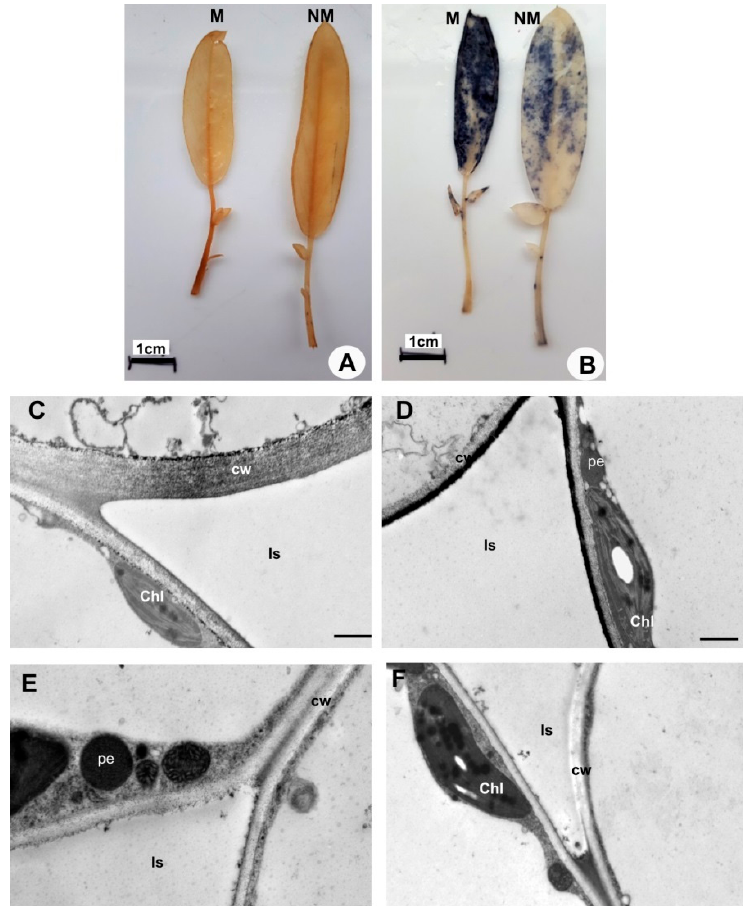
Figure 5. Localization of reactive oxygen species. Visualization of hydrogen peroxide (H 2 O 2 ) molecules by diaminobenzidine staining ( A ) and localization of superoxide anions using nitrotetrazolium blue chloride ( B ) in detached leaves. Bars = 1 cm. ( C – F ). Cytochemical localization of H 2 O 2 in mesophyll cells of metallicolous M ( C , D ) and non-metallicolous NM ( E , F ) leaves. Electron-dense deposits of cerium perhydroxides indicate H 2 O 2 localization. Chl: chloroplasts; cw: cell walls; Is-intercellular spaces; pe: peroxisome. Bars = 1 µm.